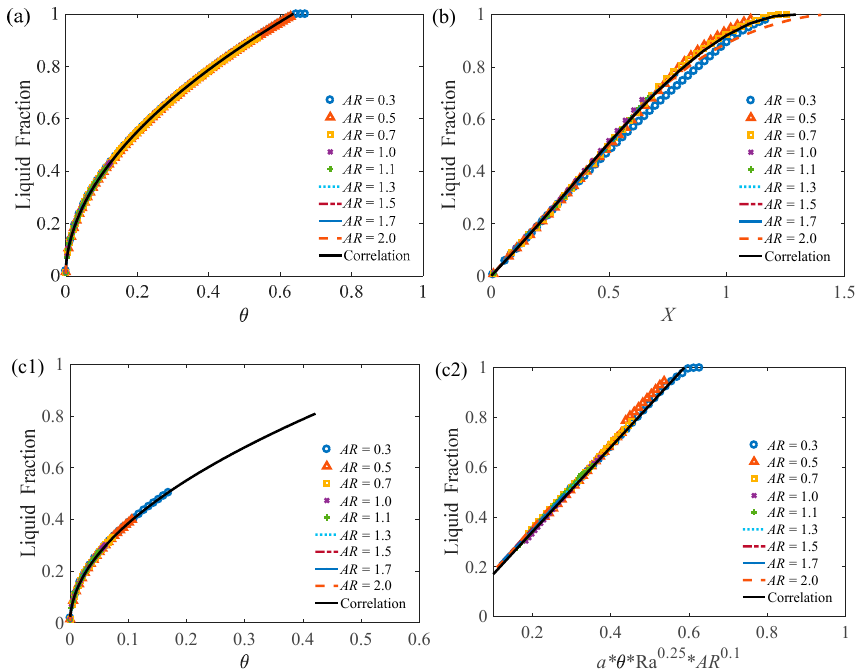
Figure 14. Unified results for the liquid fraction of PCM in rectangular enclosures with different aspect ratios. ( a ) Heating the top side; ( b ) heating the right side; ( c1 ) heating the bottom side ( θ ≤ θ c ); ( c2 ) heating the bottom side ( θ > θ c ).